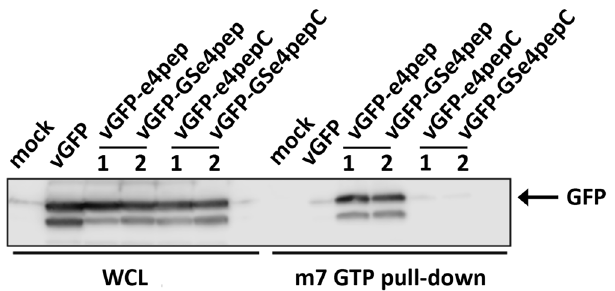
Figure 8. Intracellular targeting of eIF4E by engineered vGFP. HEK293 cells were transfected with indicated constructs and eIF4E complexed proteins isolated by pull-down using m7GTP beads. Immunoblot shows interaction with vGFP-e4pep/vGFP-GSe4pep but not controls vGFP-e4pepC/vGFP-GSe4pepC. WCL whole cell